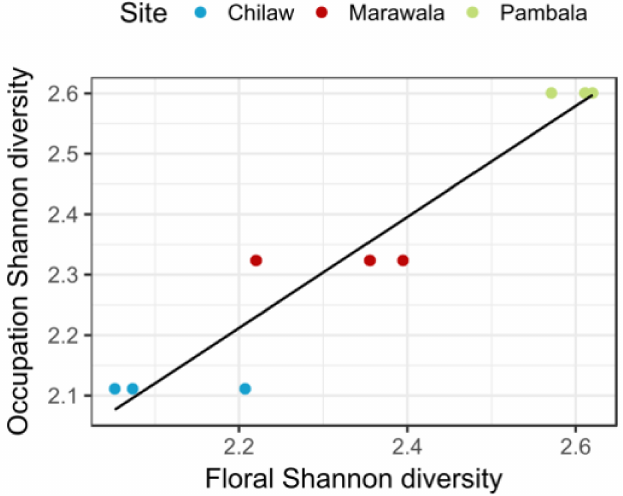
Figure 6. Relationship between the diversity of occupations in the resident communities and the Shannon diversity of the three respective sites. The solid line indicates the slope of the relationship that was obtained from a linear effects